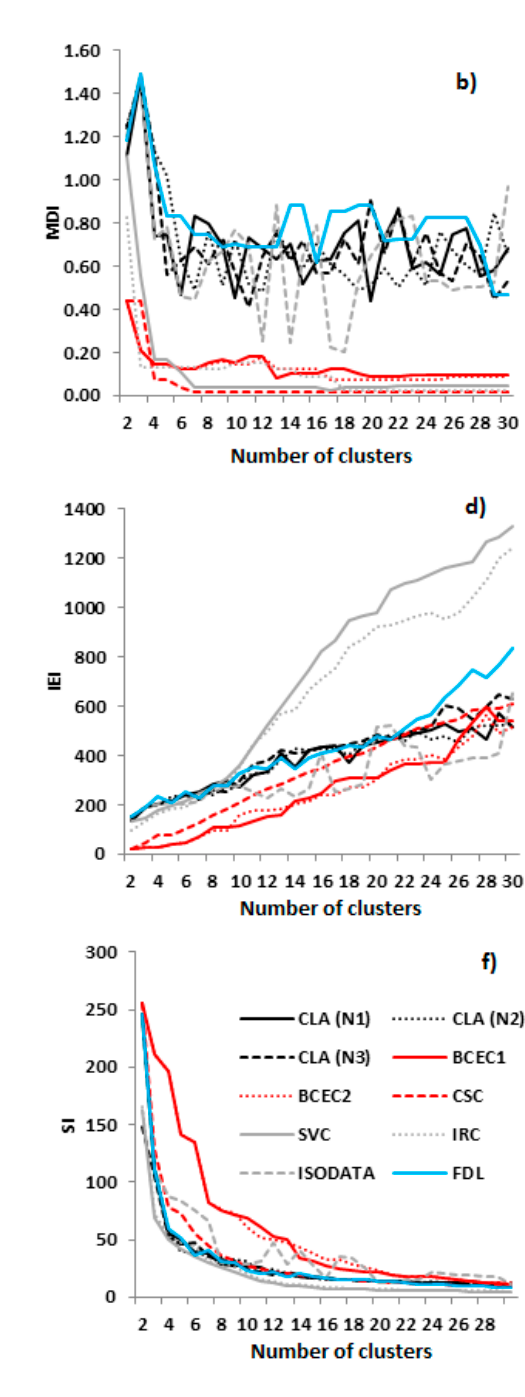
Figure 10. Comparison of the rest algorithms using: ( a ) DBI, ( b ) MDI, ( c ) IAI, ( d ) IEI, ( e ) CH, ( f ) SI. For the SVC, the parameters are set to C = 1 and q = 1. For the ISODATA, the following values are selected: Threshold of number of patterns in a cluster is equal to 15, the threshold of distance for cluster merging equals 10 and the maximum number of iterations is also 10. From comparing the algorithms, it is shown that CLA leads to lower scores in J, IAI, SMI and SMI2. The most superior operation in CDI and CH is observed from FDL. In the case of the CDI, the difference between FDL and CLA is not large. In the cases of MIA and WCBCR, IRC is more efficient than the rest. Finally, CSC outmatches the rest in DBI and MDI and SVC in IEI and SI. From the comparison of the algorithms of the rest category, CLA is